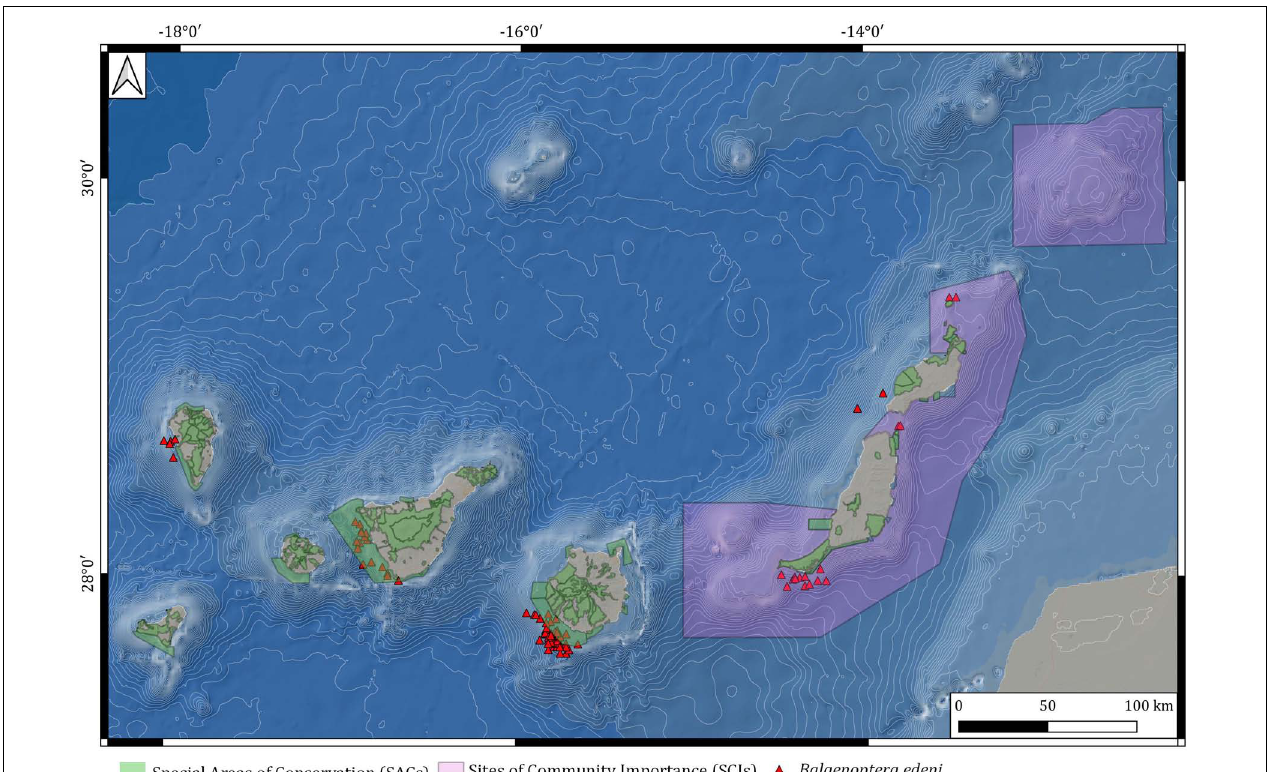
FIGURE 10 | Balaenoptera edeni spatial distribution around the Canary archipelago (red triangles), including the Special Areas of Conservation (SACs; green color) and the Sites of Community Importance (SCIs; pink